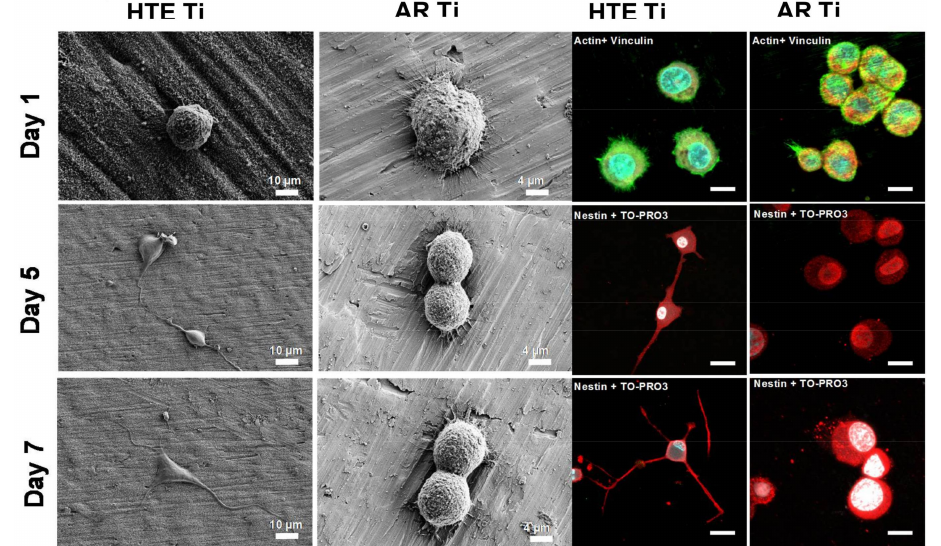
Figure 3. PC 12 cell morphology on HTE and AR Ti surfaces. The PC 12 cells were only able to differentiate on the surfaces of the nanostructured substrata in the presence of nerve growth factors (NGFs). No differentiation was observed on the non-structured AR surfaces. Expression of nestin was observed on the differentiated PC12 cells grown on the HTE-Ti substrates over a 7-day period. Immunohistochemical staining (nestin, red) of the PC12 cells showed that the cells could be differentiated on the surface of the nanostructured substrates. The cells exhibited an enhanced neurite elongation and expression of nestin, as seen on days 5 and 7. The PC12 cells grown on the AR surfaces were not observed to differentiate (scale bar = 3 µ m). Actin (green) and vinculin (red) were labelled on day 1 to enable the determination of cell attachment